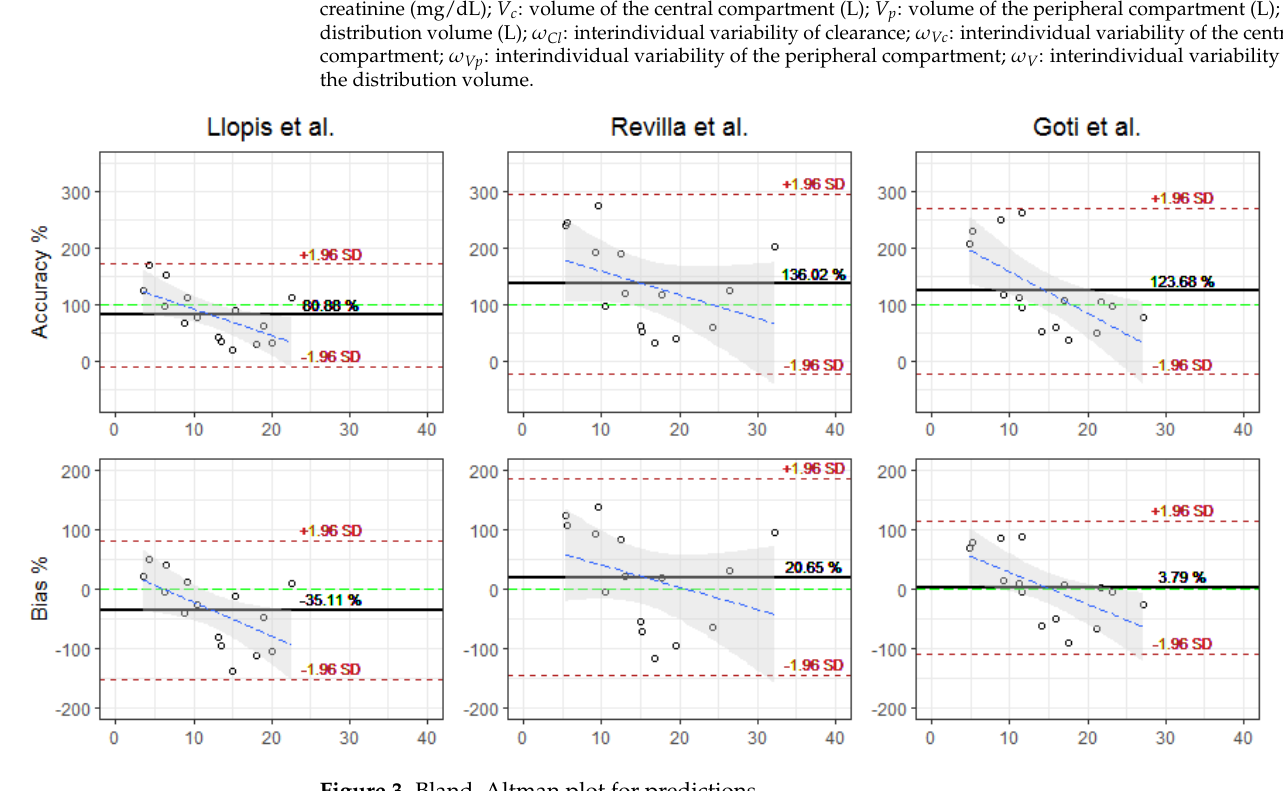
Figure 3. Bland – Altman plot for predictions. Figure 3. Bland–Altman plot for